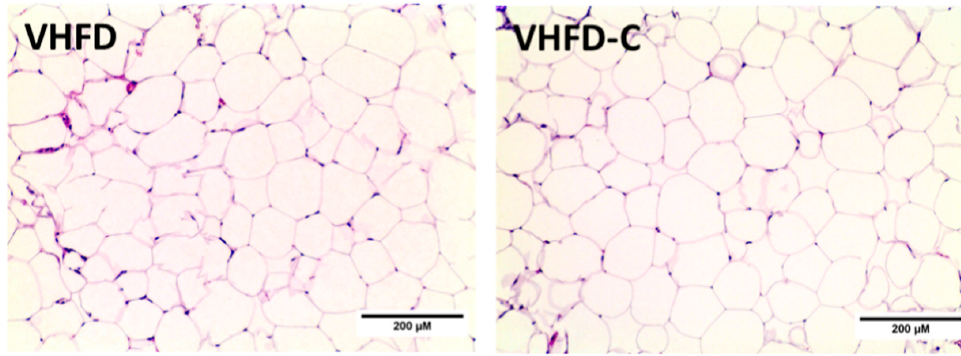
Figure 4. Histologic evaluation of white adipose tissue (WAT). Effect on curcumin on WAT cellularity. Representative images of hematoxylin and eosin (H&E)-stained sections. Magnification 200×; n = 4. Biomolecules 2020 , 10 , x